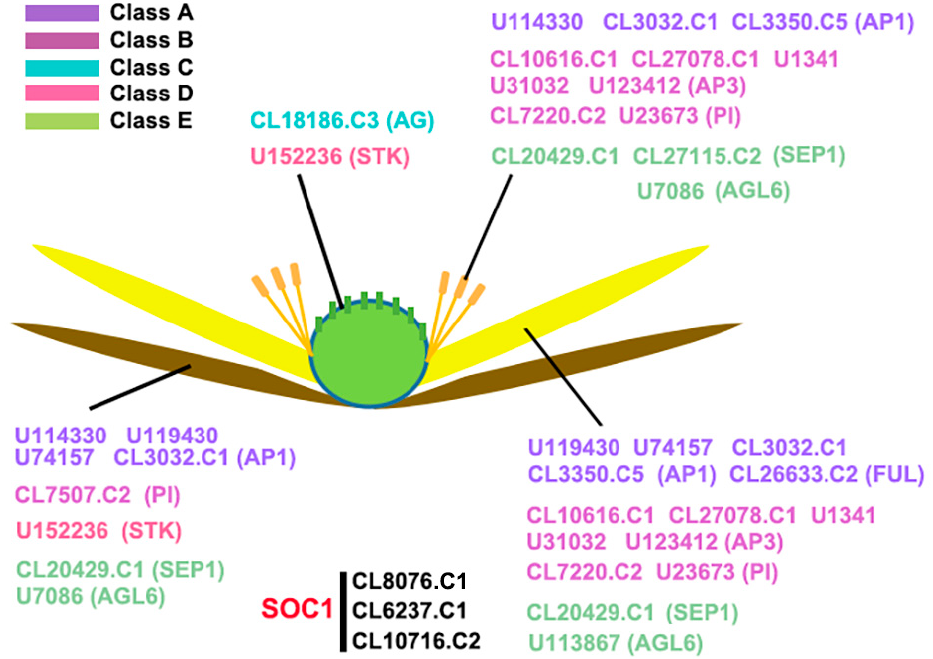
Figure 8. Hypothetical model of expression pattern of AaMADS genes. Five colors represent five class AaMADS genes, including class A, B, C, D, and E.